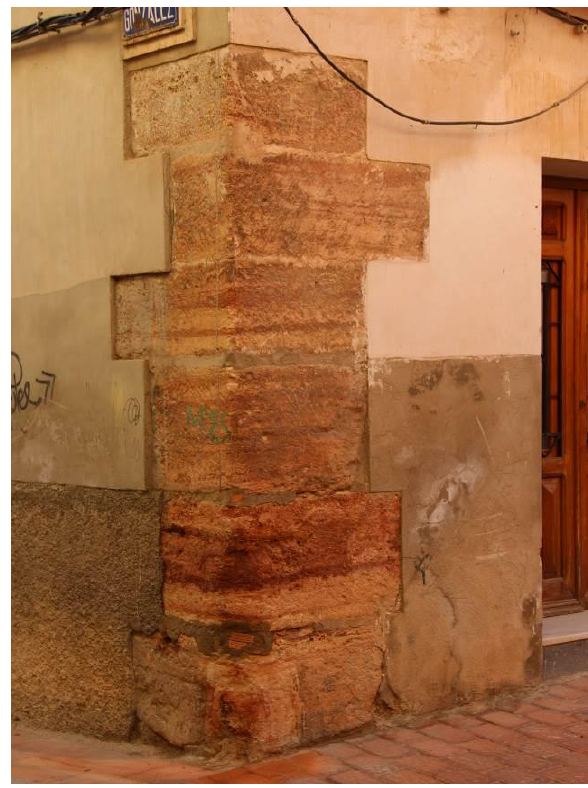
Figure 13. Detail of an Almagra stone corner plinth in Mula (Source: authors).